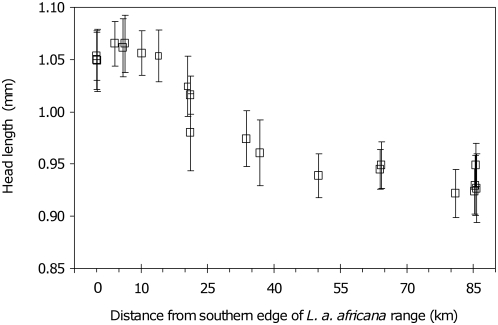
Body size of female sexuals of P. phylax increases southward.Geographic cline of within-population variation (mean±standard deviation) of head length, a surrogate of queen size, measured over 1,036 individuals from 256 colonies in 21 populations of the ant P. phylax.